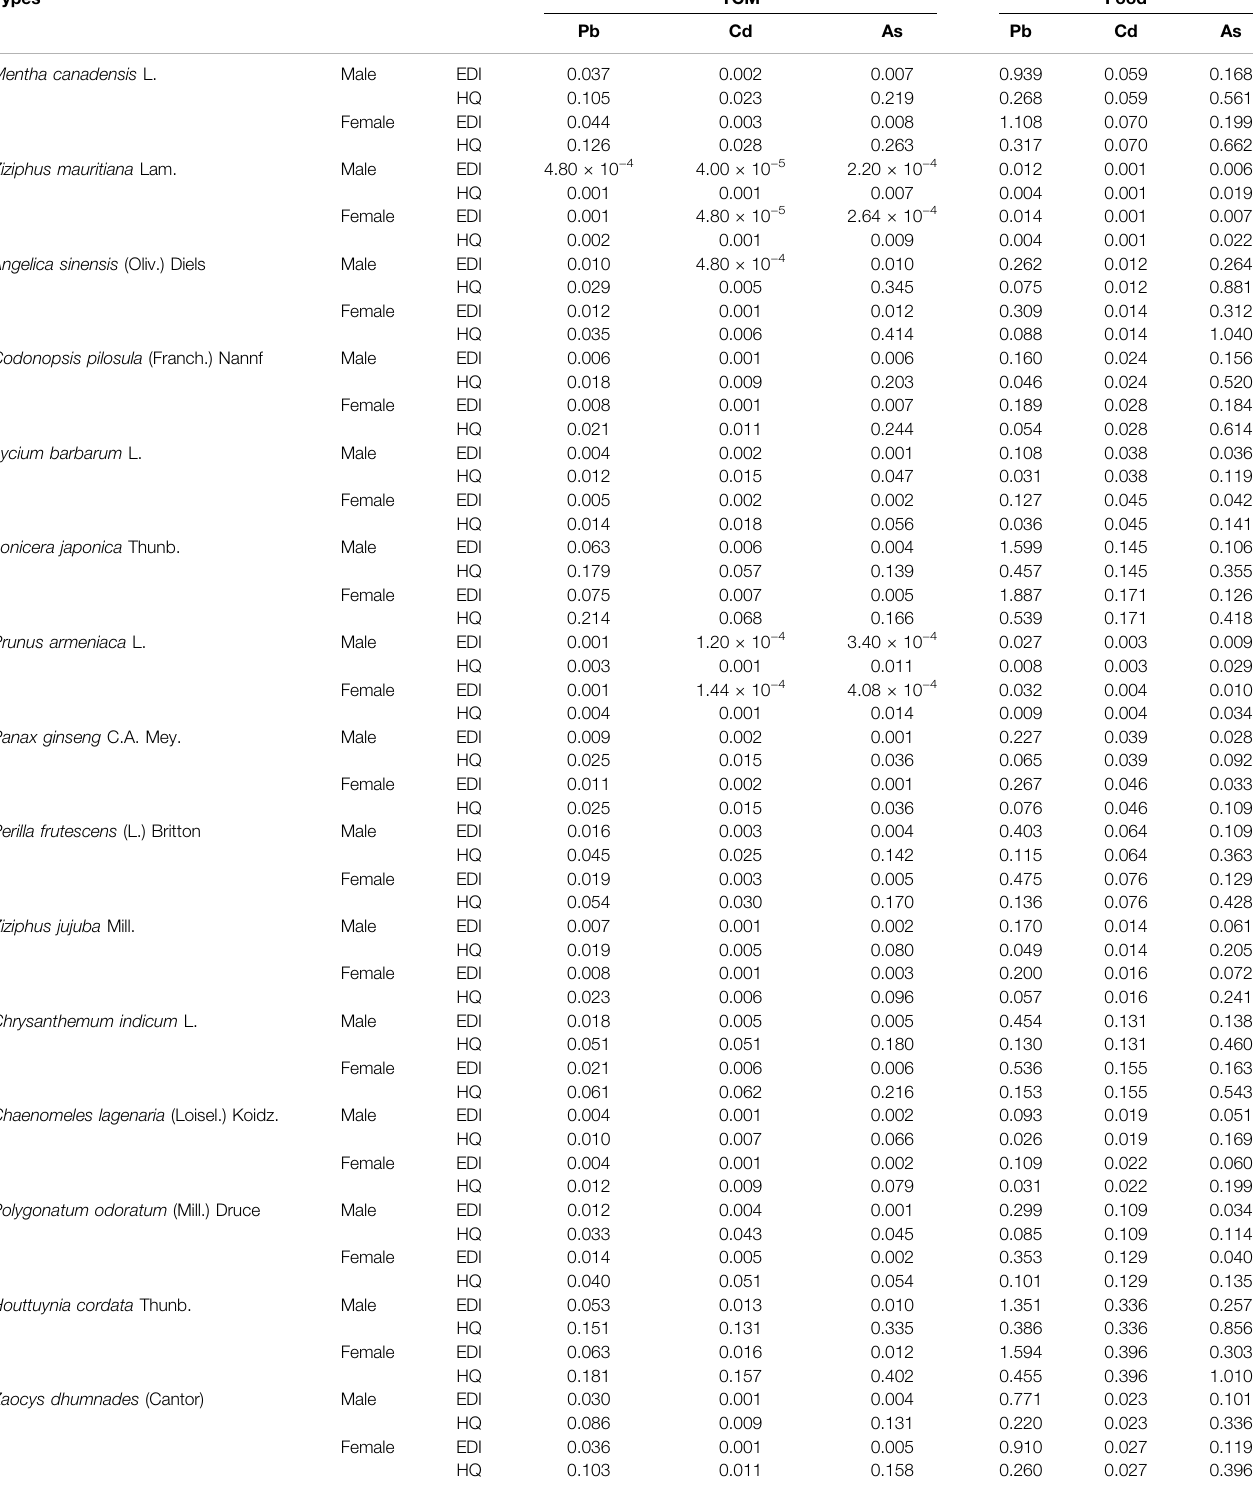
TABLE 3 | EDI ( μ g/kg/d) and HQ for heavy metals due to consumption of MFHV used as TCM and food, respectively. Types